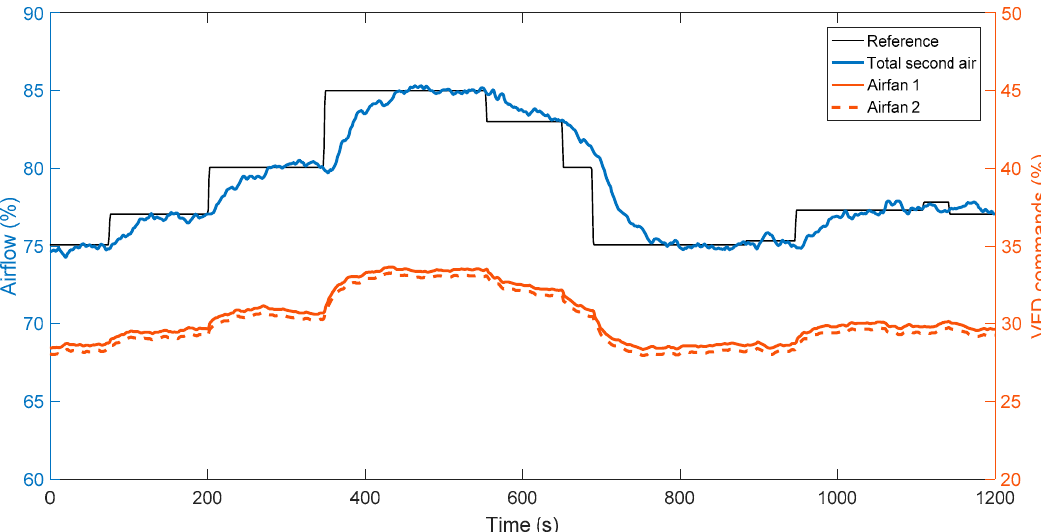
Figure 14. Reference step test results of the ADRC in the CFB unit (time span of test: 1 September 2017, 9:28:50–9:48:50).